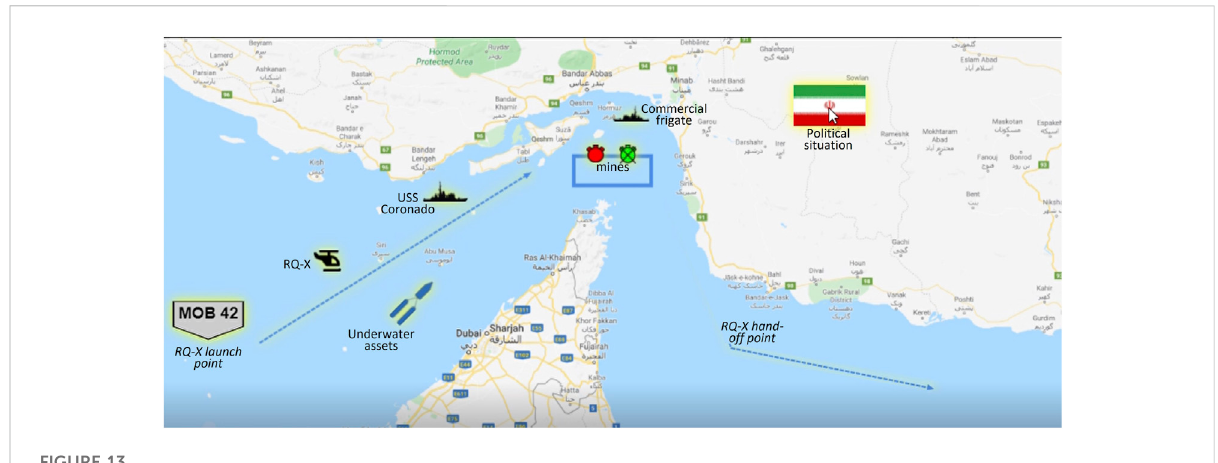
Second panel of the quick overview version of the